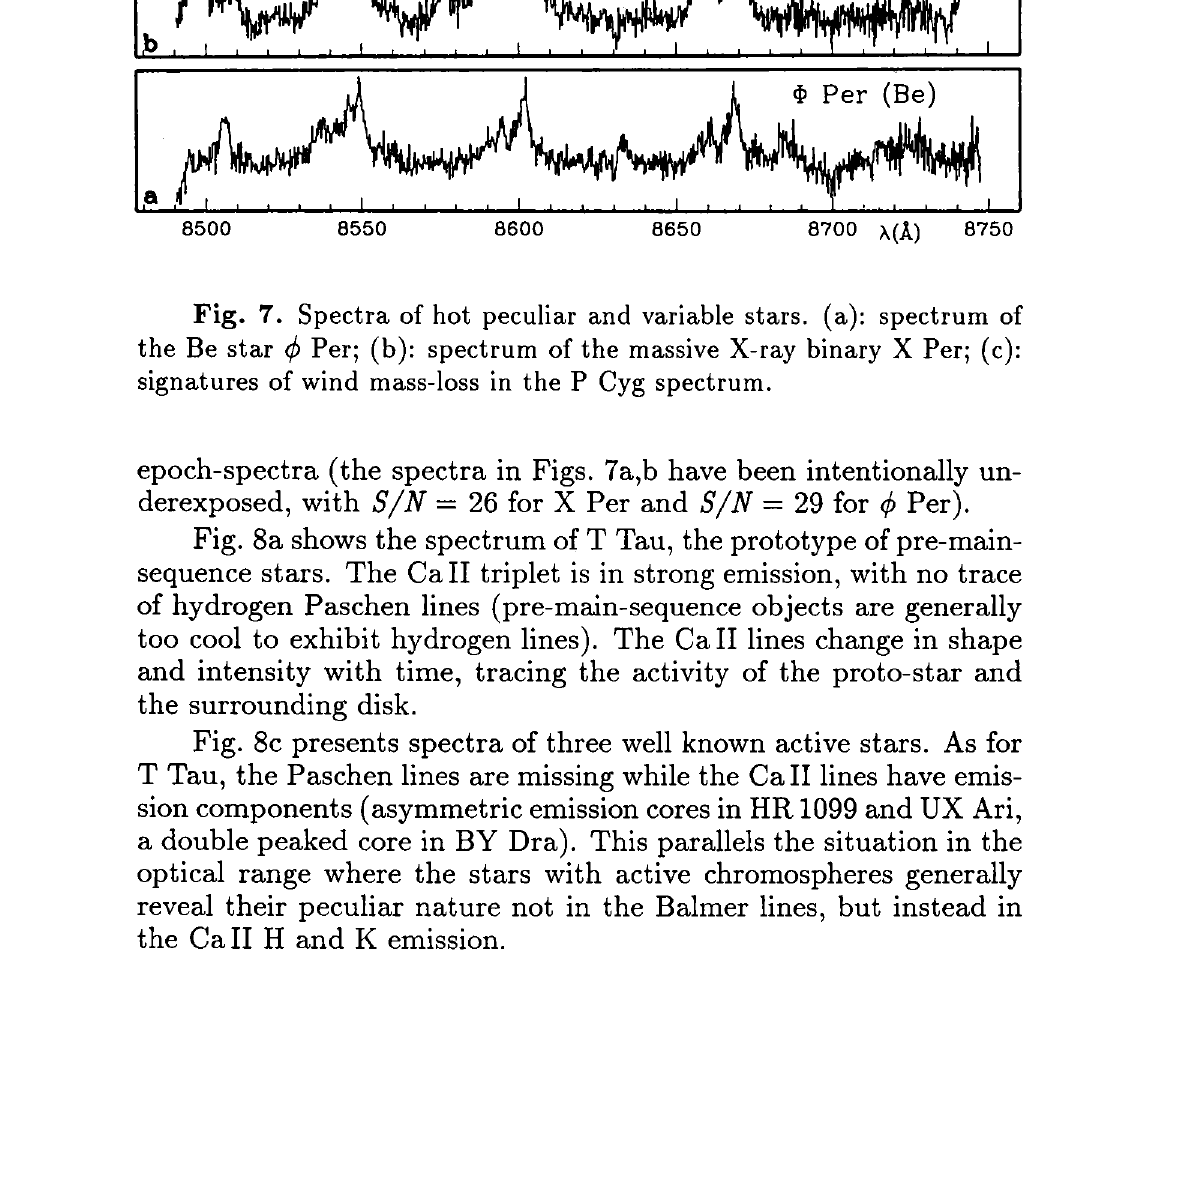
Fig. 7. Spectra of hot peculiar and variable stars, (a): spectrum of the Be star φ Per; (b): spectrum of the massive X-ray binary X Per; (c): signatures of wind mass-loss in the Ρ Cyg